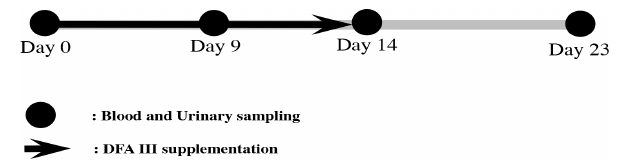
Figure 1. Experimental protocol for DFA III supplementation in dietary feed and sampling of blood and